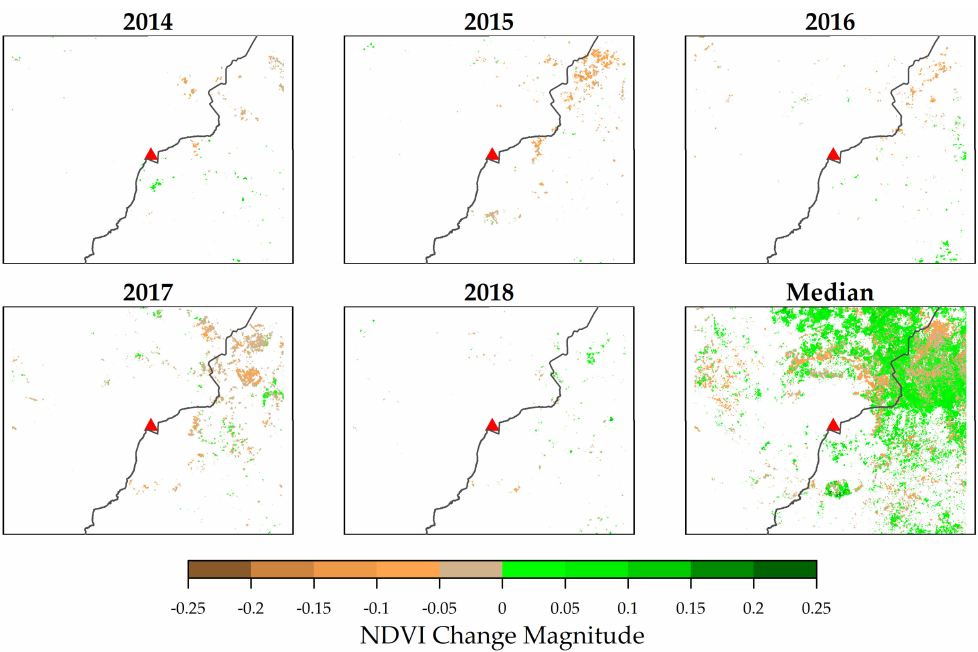
Figure 11. Greening and browning in the MEE. The results from bfastSpatial using NDVI time series (2001–2018) while sequentially monitoring each year in 2005–2018. These maps show magnitudes of change for pixels with significant breakpoints.